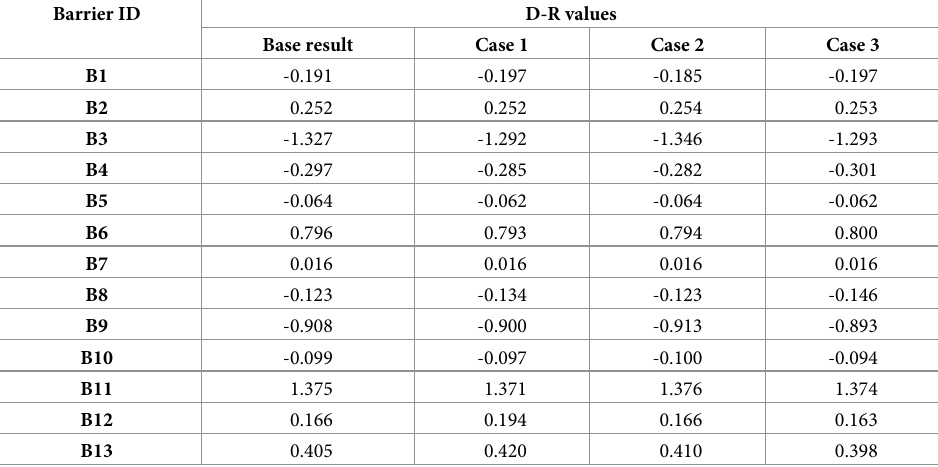
Table 7. Comparison among different cases of sensitivity analysis and the base result.